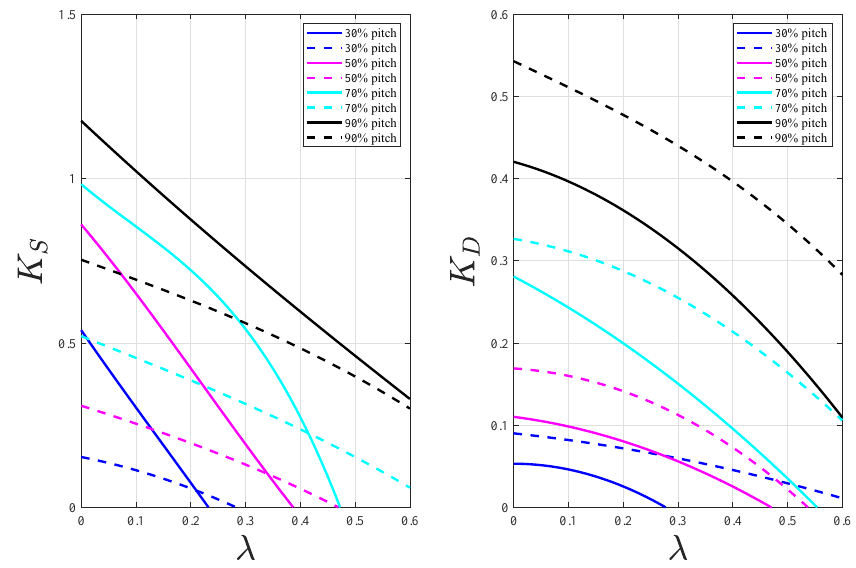
Figure 5. Thrust and torque propeller coefficients: model (solid lines) VS manufacturer data (dashed